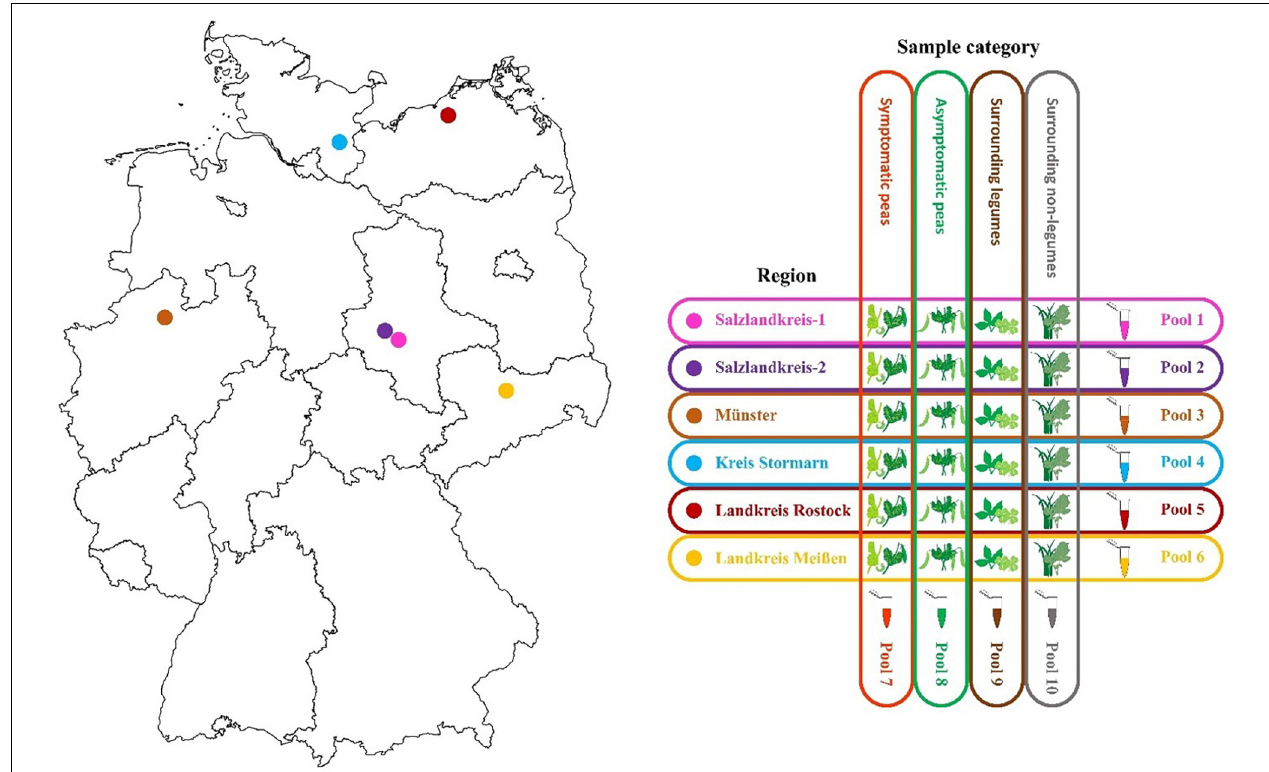
FIGURE 1 | Map of the six different pea crop sampling regions in Germany and the sample pooling strategy used for each of three successive seasons 2016, 2017, and